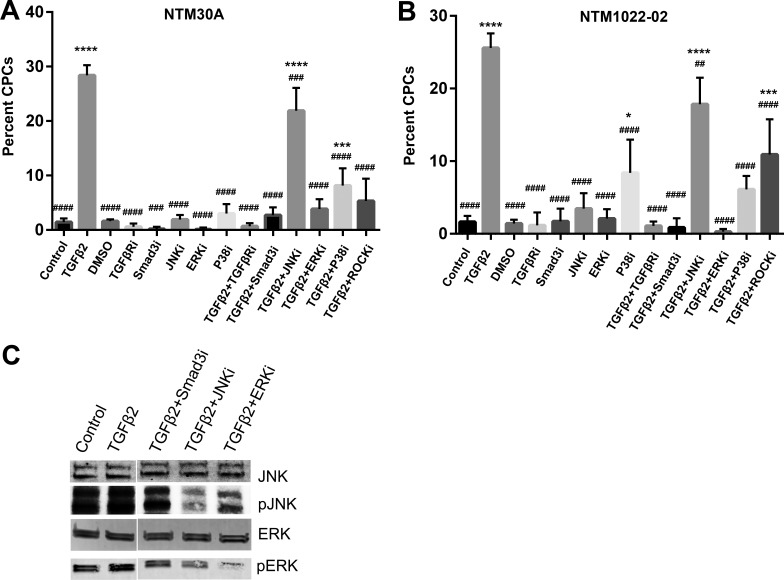
Prevention of CLAN formation in NTM cells by TGFβ pathway inhibitors. (A) NTM30A and (B) NTM1022-02 cells cultured on glass coverslips (n = 6 to 12) were treated with control or TGFβ2 with or without indicated TGFβ Smad or non-Smad pathway inhibitors for 10 days. Percentage of CPCs was compared using 1-way ANOVA with Dunnett's multiple comparisons post hoc test. Columns and bars: means and SEM. *P < 0.05 for the group of interest versus control; ***P < 0.001, ****P < 0.0001, and ##P < 0.01 for the group of interest versus TGFβ2; ###P < 0.001; ####P < 0.0001. TGFβRi, TGFβ receptor inhibitor (SB431542; 5 μM); SMAD3i, Smad3 phosphorylation inhibitor (SIS3; 10 μM); JNKi, JNK pathway inhibitor (SP600125; 10 μM); ERKi, ERK pathway inhibitor (U0126; 25 μM); P38i, P38 pathway inhibitor (SB203580; 5 μM); ROCKi, ROCK pathway inhibitor (Y27632; 10 μM). (C) NTM1022-02 cells were treated with TGFβ2 with or without indicated inhibitors, and whole cell lysates were collected for WB. pJNK, phosphorylated JNK; pERK, phosphorylated ERK.